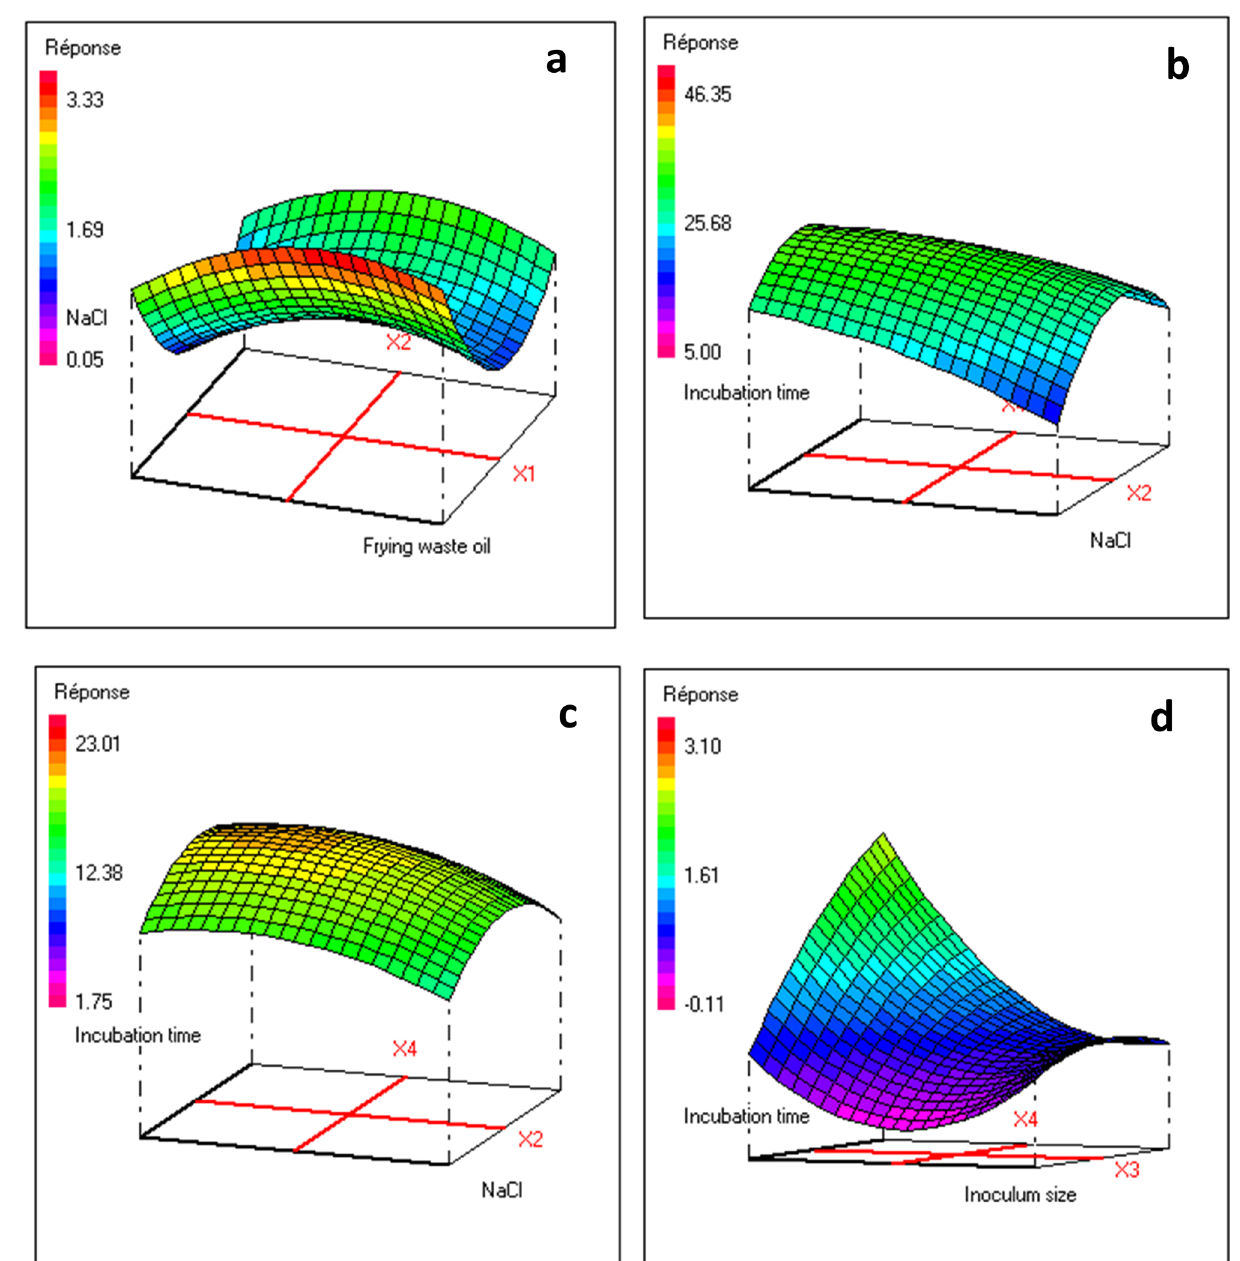
Figure 1. Three-dimensional response surface for the effect of waste frying oil, inoculum size, [NaCl] and incubation time on the response Y1 ( a ), Y2 ( b ), Y3 ( c ) and Y4 ( d ). The response surface graphs were generated by NEMROD-W statistical software (design NEMROD-W, version 9901 Française, LPRAI-Marseille Inc., France) (https:// www. nemro dw. com/